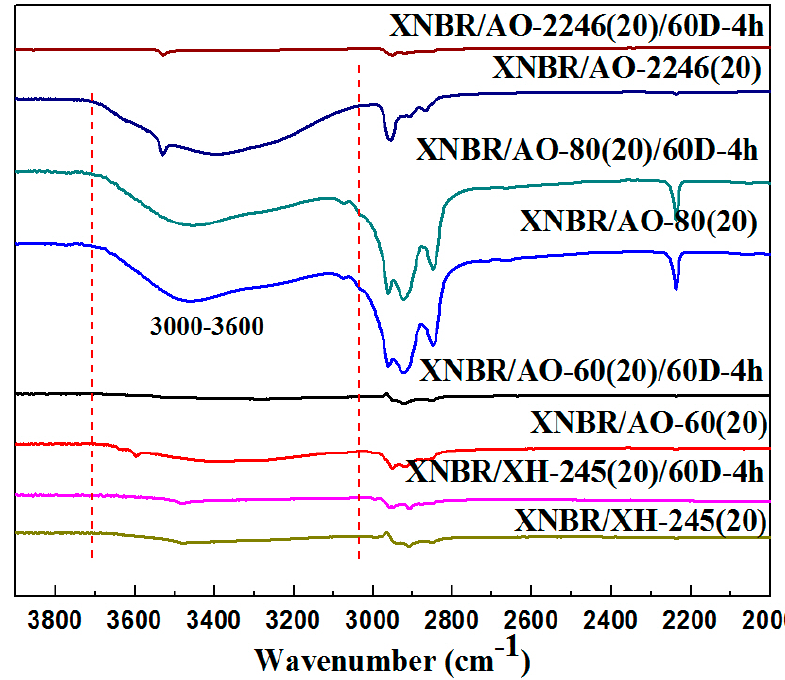
Figure 12. FT-IR spectrum of XNBR/hybrid phenol composites.